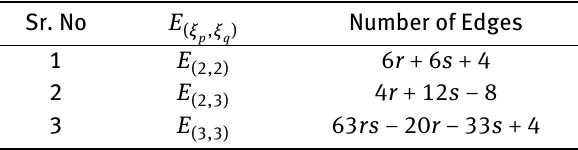
Table 3: The distribution of edges of multiple Anthracene w.r.t. degree of end vertices of every edge.